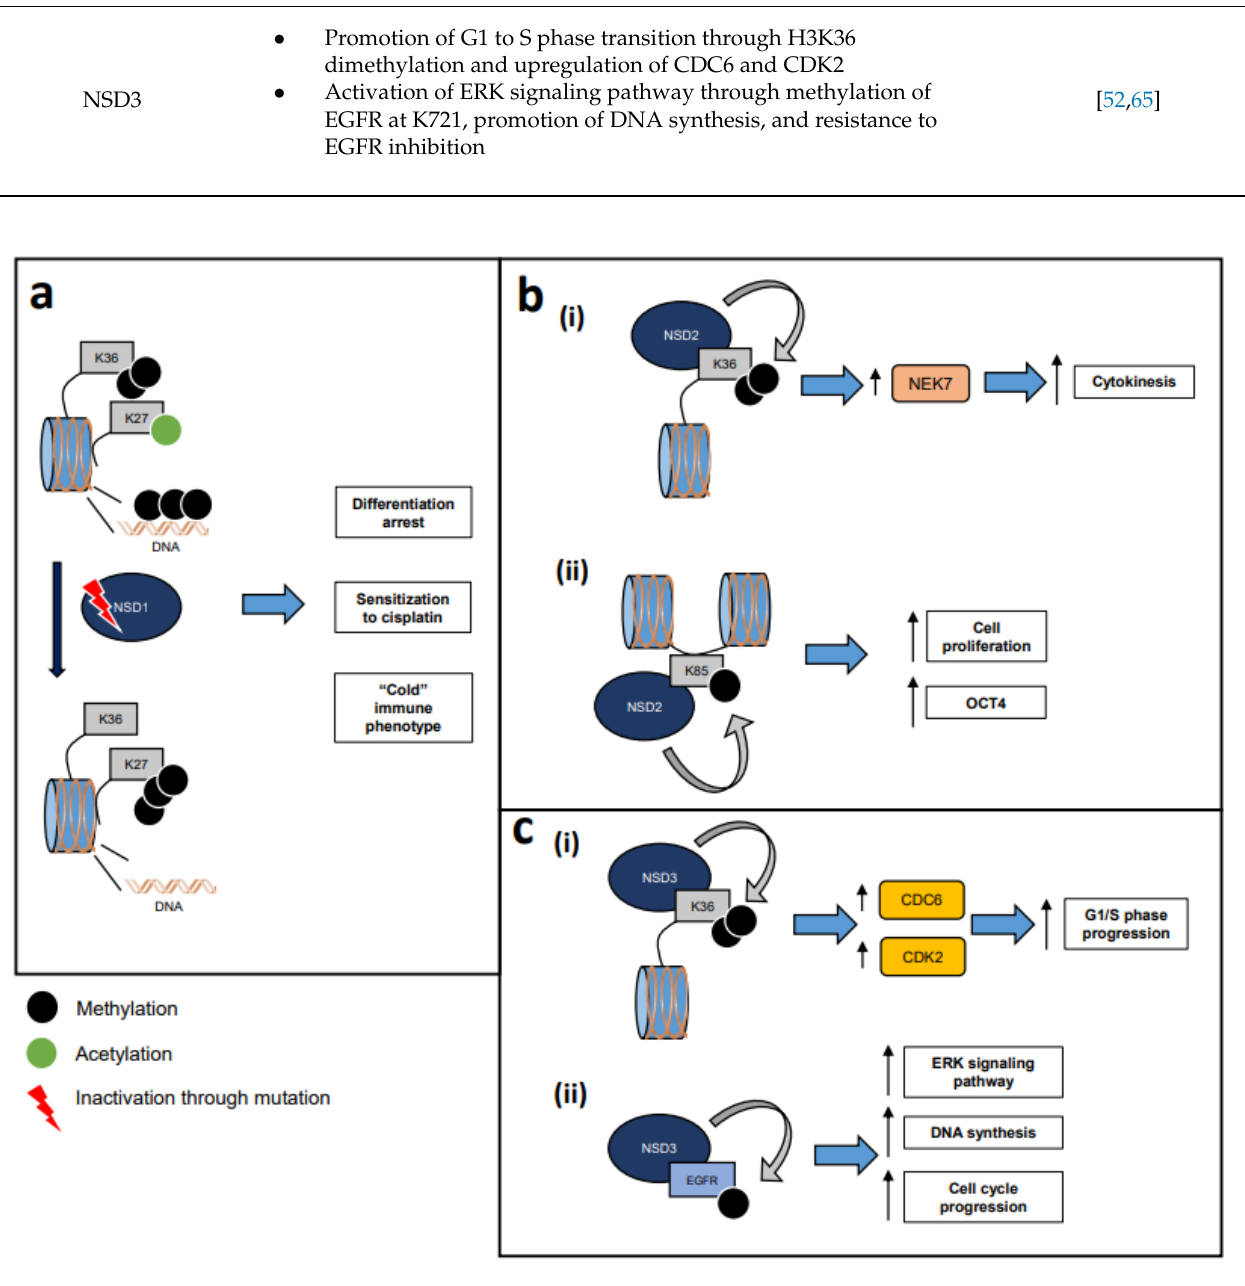
Figure 1. Reported mechanisms of action of the NSDs in HPV-negative HNSCC. ( a ) Inactivating mutations of NSD1 in HPV-negative HNSCC induce decreased levels of H3K36me2, global DNA hypomethylation and increased levels of H3K27me3, leading to differentiation arrest, increased sensitivity to cisplatin, and a “cold” immune phenotype. ( b ) NSD2 in HNSCC. (i) NSD2 dimethylates H3K36, leading to NIMA-related kinase 7 (NEK7) upregulation to promote cytokinesis. (ii) NSD2 monomethylates H1K85, promoting pathways related to cell proliferation and upregulating OCT4, a stemness factor. ( c ) NSD3 in HNSCC. (i) NSD3 dimethylates H3K36, leading to CDC6 and CDK2 upregulation and promotion of G1-S phase progression. (ii) NSD3 methylates epidermal growth factor receptor (EGFR) at lysine 721, increasing interaction with PCNA to enhance DNA synthesis and promote cell cycle